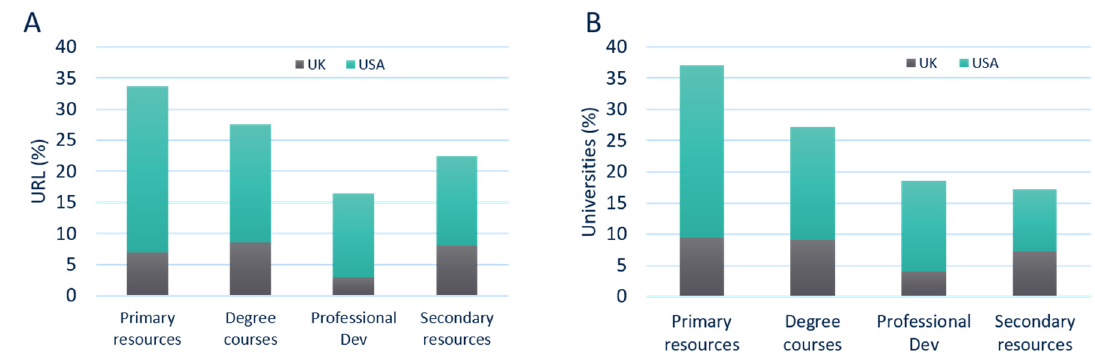
Figure 2. Results showing what kind of regulatory support is provided by academia. ( A ) This graph shows the percentage of URL’s that link to one of the four content categories: primary resources, degree courses, professional development and secondary resources; ( B ) This graph shows the percentage of Universities that provide a link to one of the aforementioned four regulatory content categories.